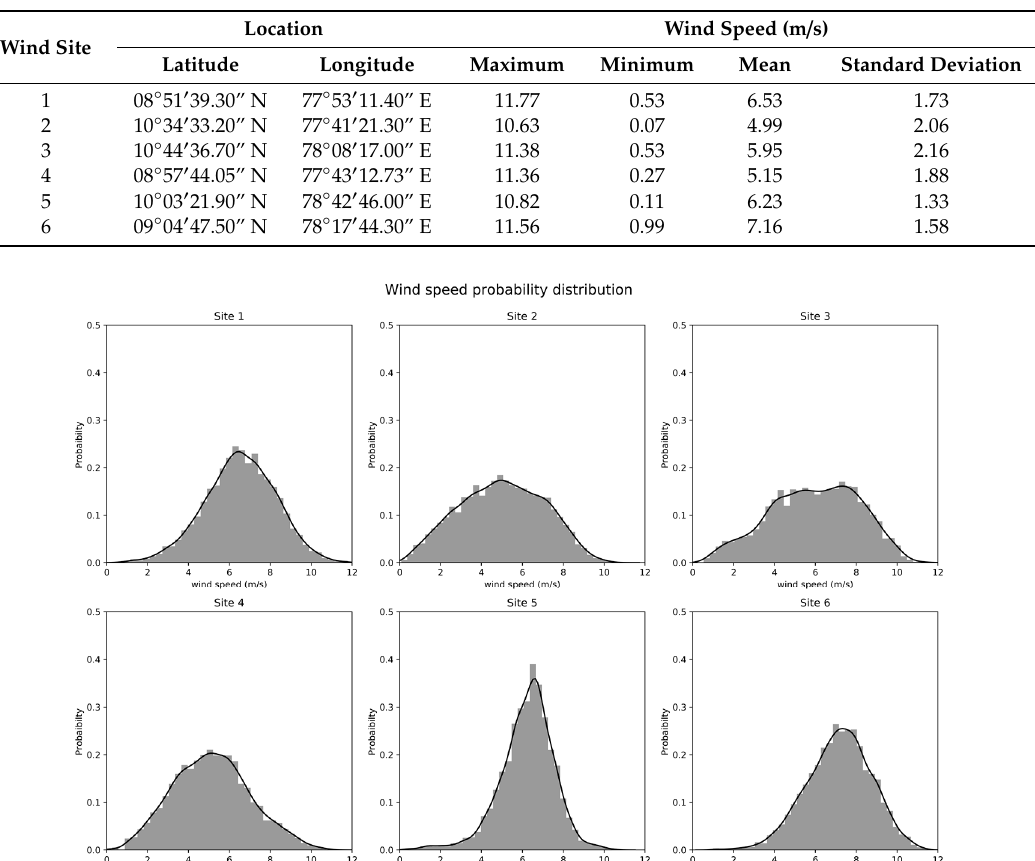
Table 8. Wind sites’ location and wind speed statistical features.